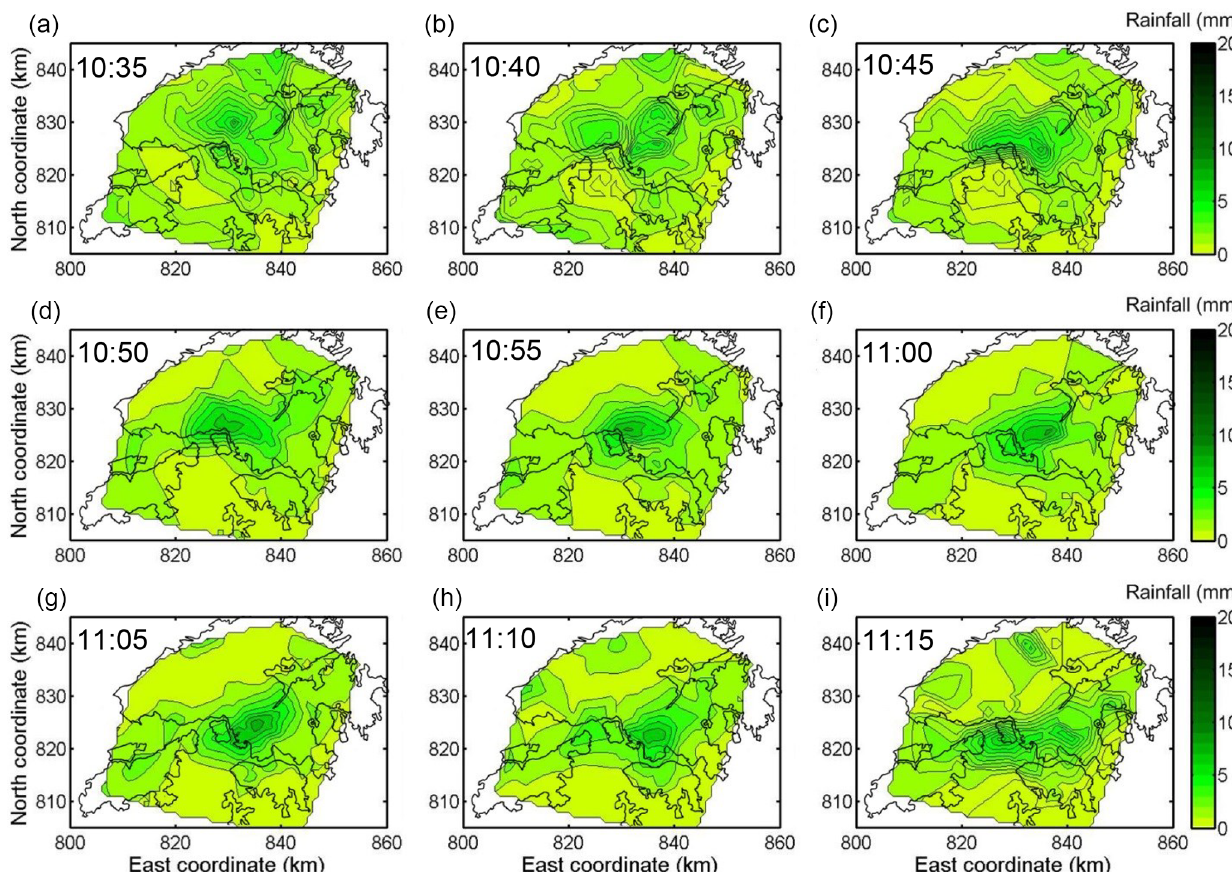
Figure 10. Instantaneous rainfall process from 10:35 to 11:15LT on 20 August